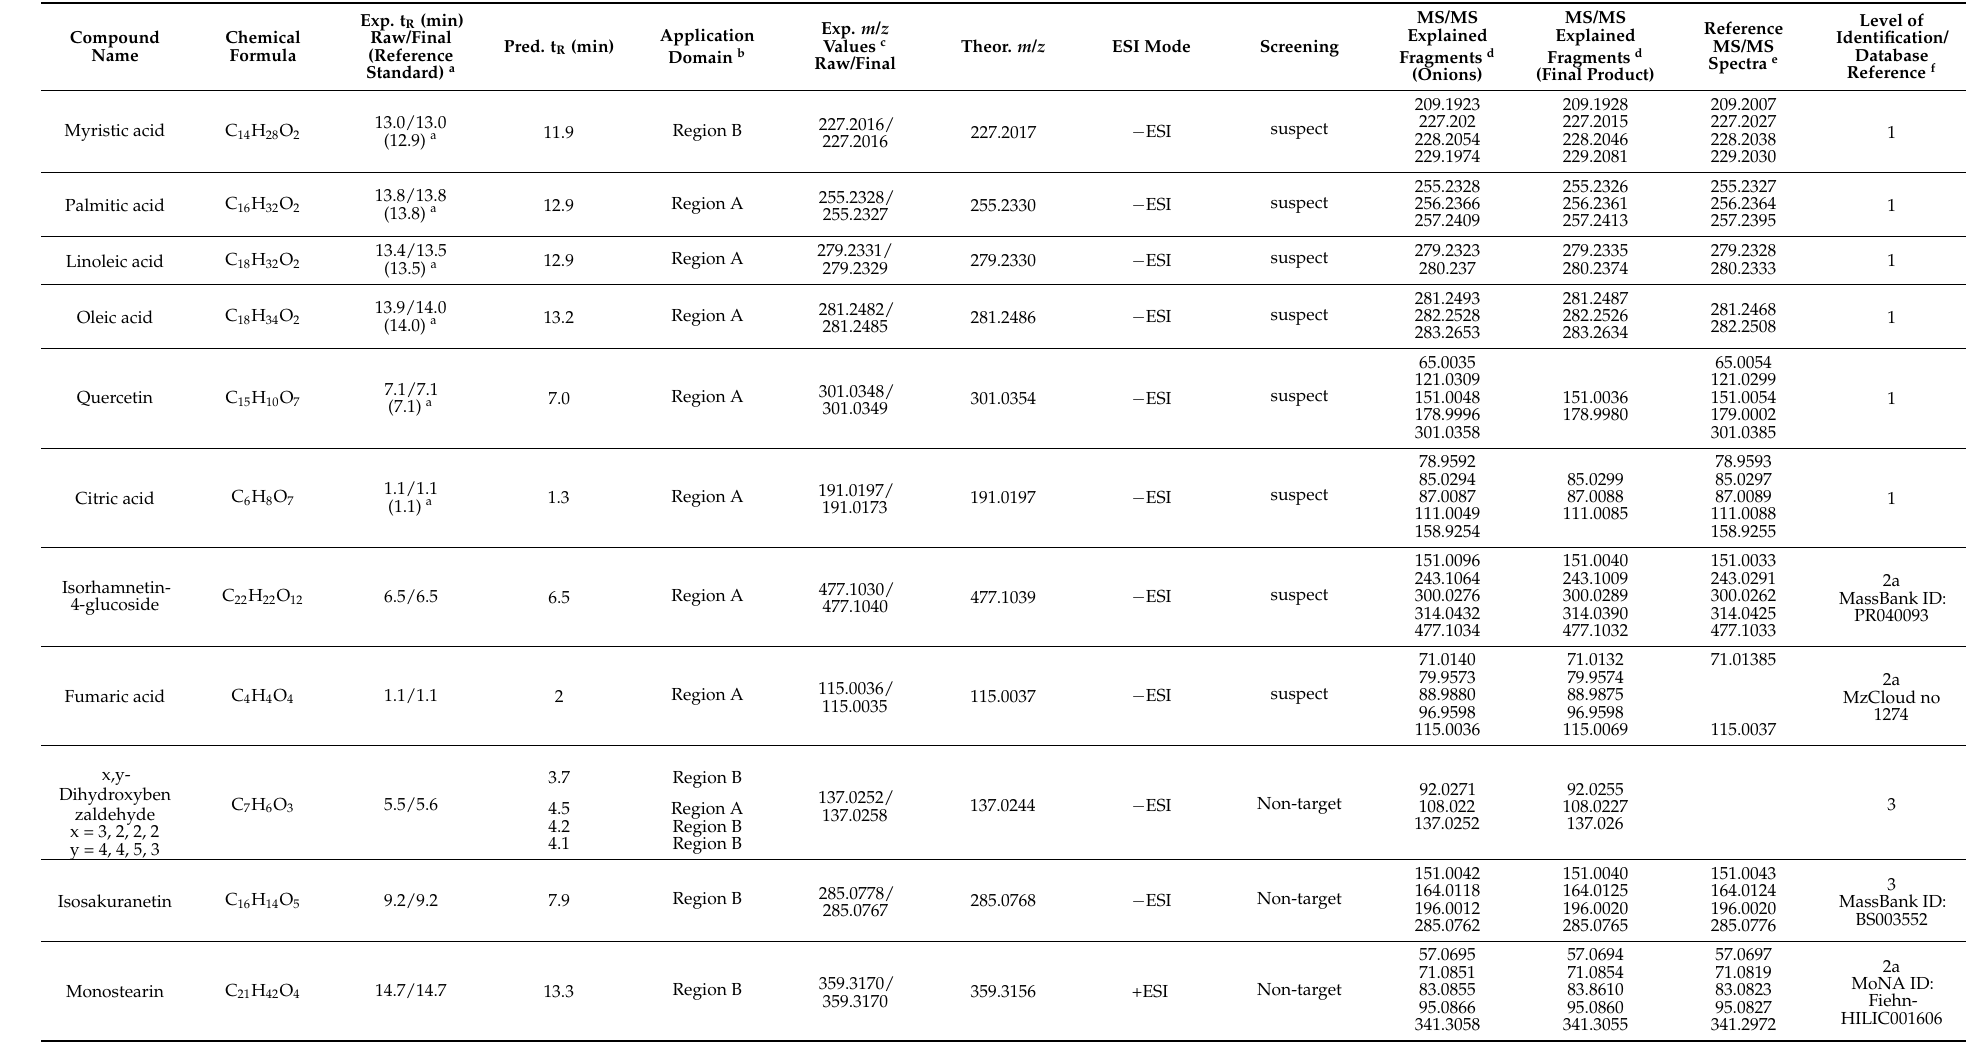
Table 1. Compounds identified through suspect and non-target screening in the raw material (onion) and onion-based final